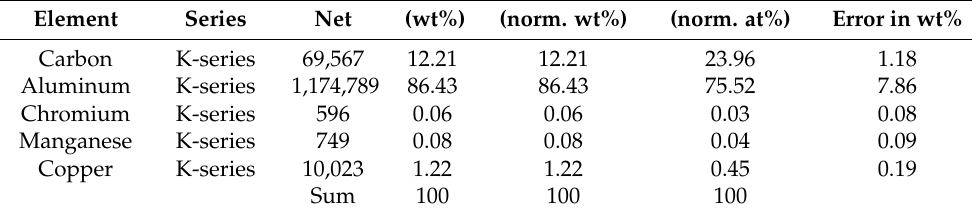
Table 3. Element in location B of the thixoformed part soaked for 10 min at 590 ◦ C.